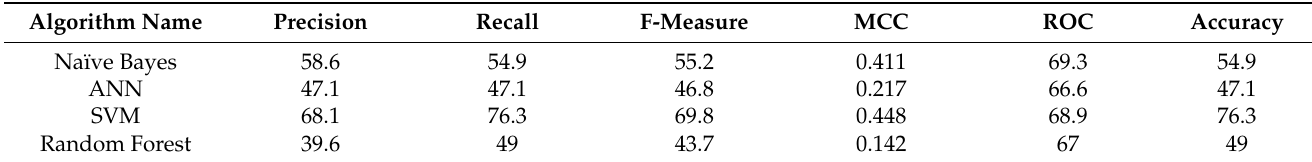
Table 8. Comparison among classification algorithms using 10-fold cross-validation testing to predict the total